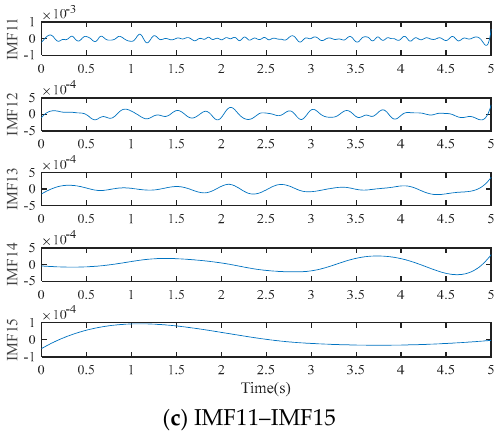
Figure 11. Results of fault signal analyzed by EEMD.